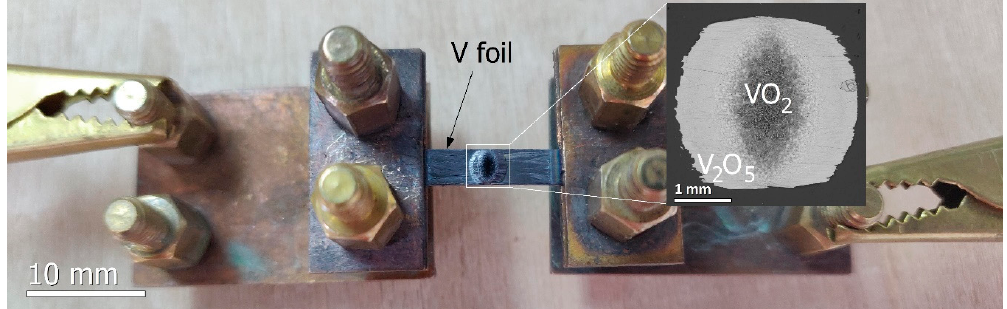
Figure 1. Photo of partial experimental setup. The inset is the SEM image of as-fabricated single-crystalline VO 2 microtube arrays on on V 2 O 5 substrate.